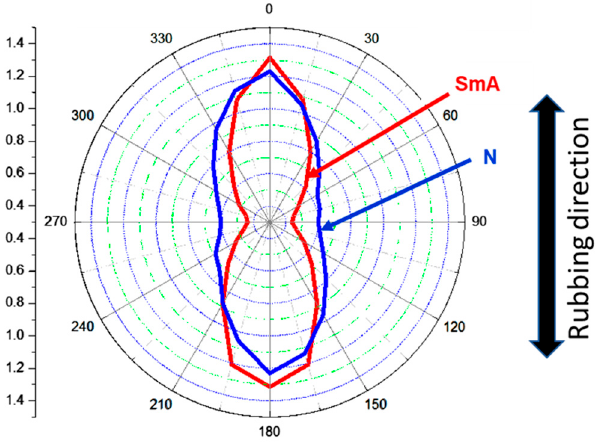
Figure 3. Polar plot of the polarized absorption intensity of the blended dye molecule (PM580; 1 wt%), as a function of the sample rotation angle in the LC N (75 °C) and SmA (58 °C) phases in the planar liquid-crystalline (LC) cells.